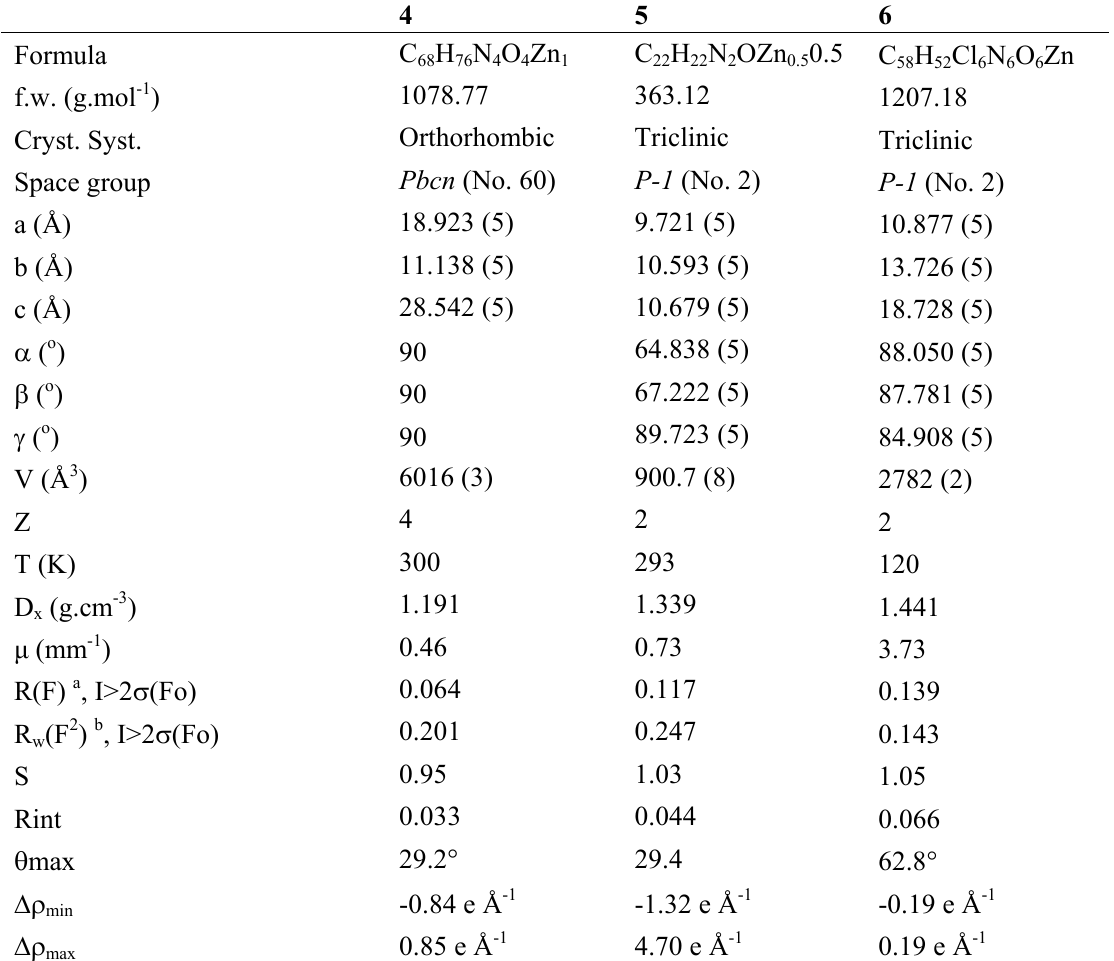
Table 1. Crystal data and selected structure refinement parameters for zinc complexes 4 , 5 and 6